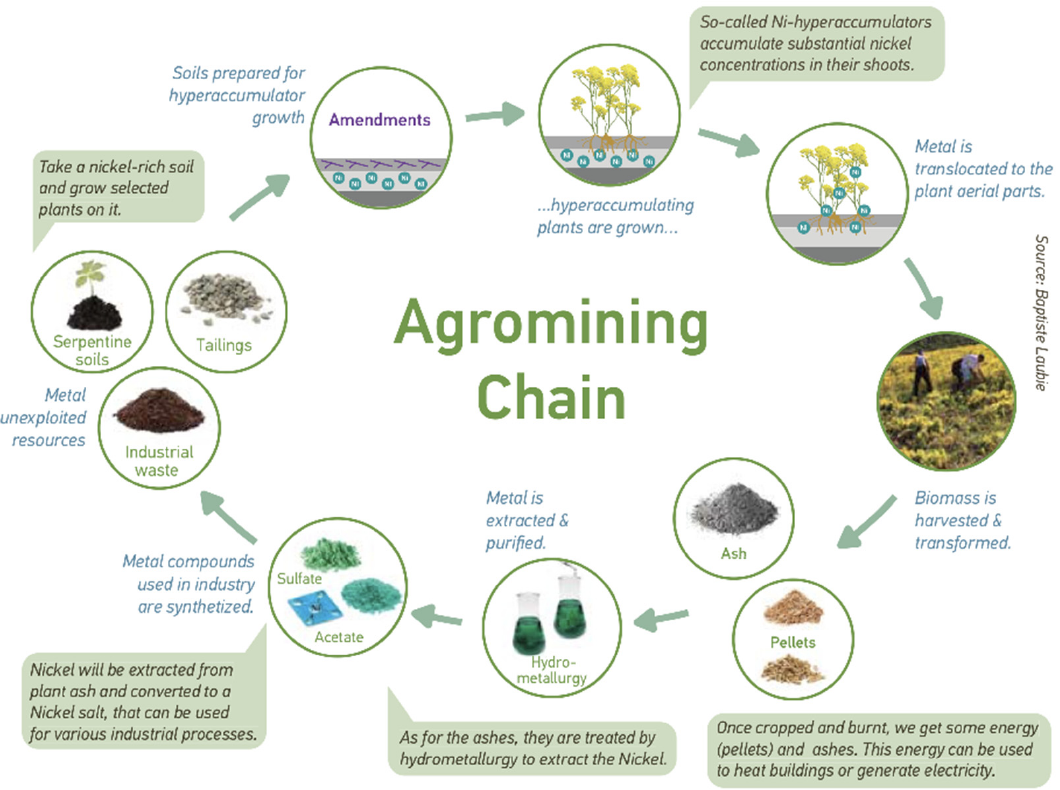
Figure 3. Agromining chain, source: Baptiste Laubie (2019), Layman’s Agromine Report published in frame of Life AGROMINE project (https://www.alchemia-nova.net/website2018/wp-content/uploads/2019/08/laymans_agromine_EN-s.pdf, accessed on 28 August 2019).